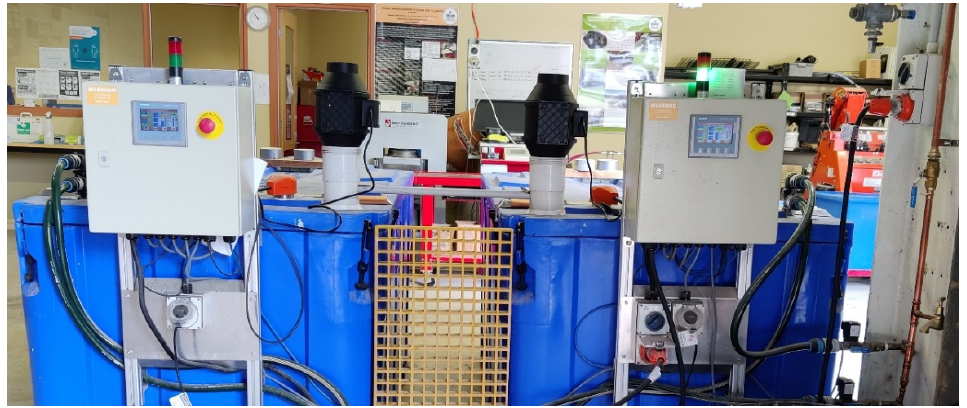
Figure 3. Control panel of the accelerated weathering tank.